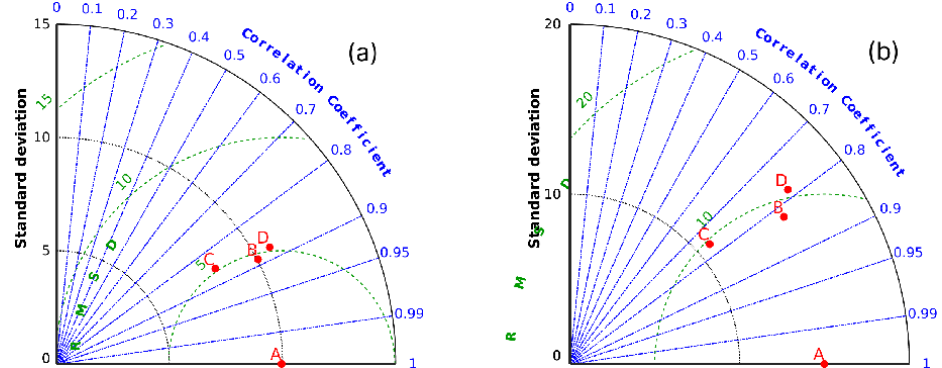
Figure 9. Taylor plots comparing LE flux models to EC measurements. Panel (a) has all the cases where the surface was freezing ( T 0 < 0 ◦ C), and in panel (b) are the cases where the surface was melting ( T 0 > 0 ◦ C). A denotes EC measurements, B is the constant C E model, C denotes the LHFA model and D stands for the SEA-ICE model.